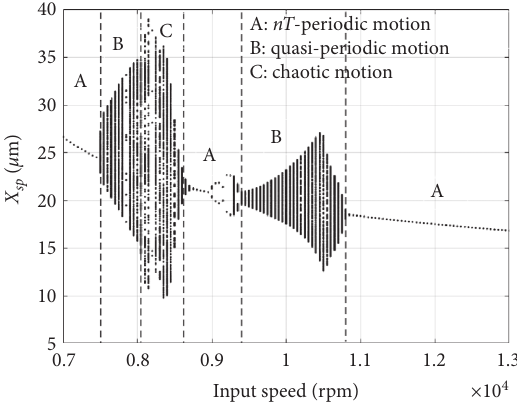
Figure 7: Bifurcation diagram of system with varying input rotational speed.